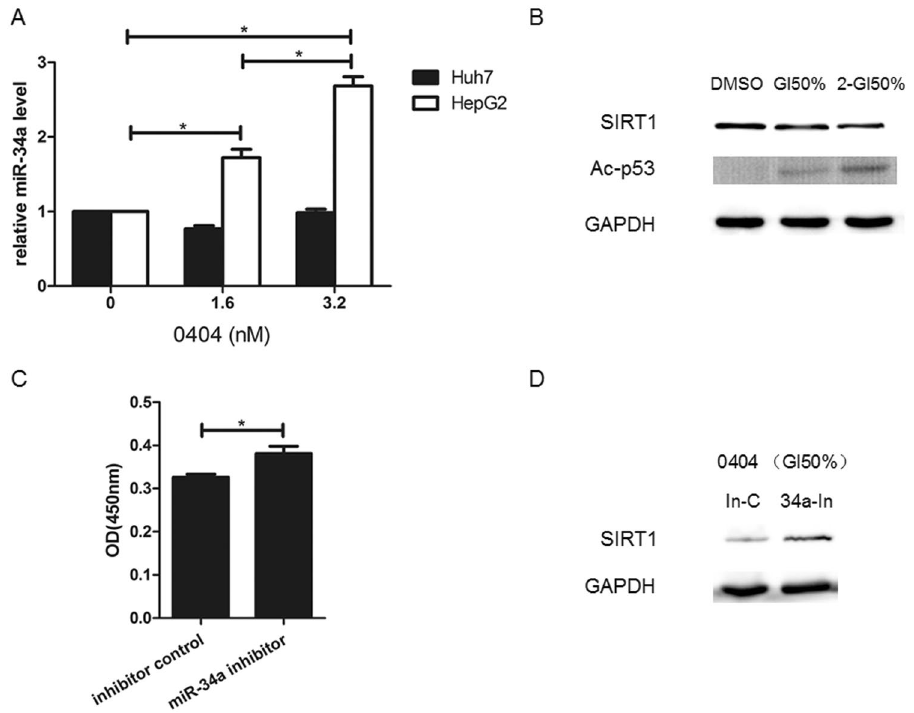
Figure 6. The anti-cancer effects of 0404 was closely related to miR-34a. ( A ) 0404 increased miR-34a level in a concentration-dependent manner in HepG2 cells (p53 WT). ( B ) Expression of SIRT1 protein and acylation of p53 after 0404 treatment. ( C ) MiR-34a inhibitor attenuated the inhibitory effects of 0404 in HepG2 growth when compared with the NC inhibitor. ( D ) SIRT1 expression significantly elevated in 0404 + miR-34a inhibitor